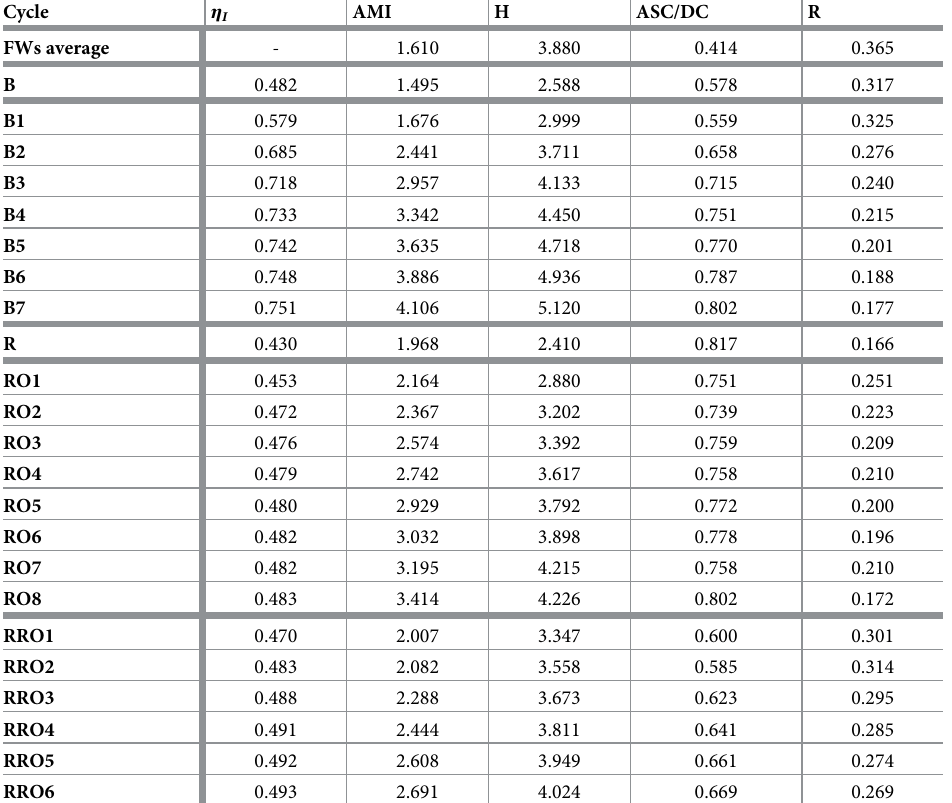
Table 3. The sets of modifications made to each cycle and the corresponding changes in thermal efficiency ( η I ), average mutual information ( AMI ), the Shannon Index ( H ), the degree of system order ( ASC/DC ), and ecosystem robustness ( R ). B1-7: Gradual addition of regeneration, intercooling and reheat. RO1-8: Gradual addition of open feed-water heaters. RRO1-6: Gradual addition of reheat and open feed-water